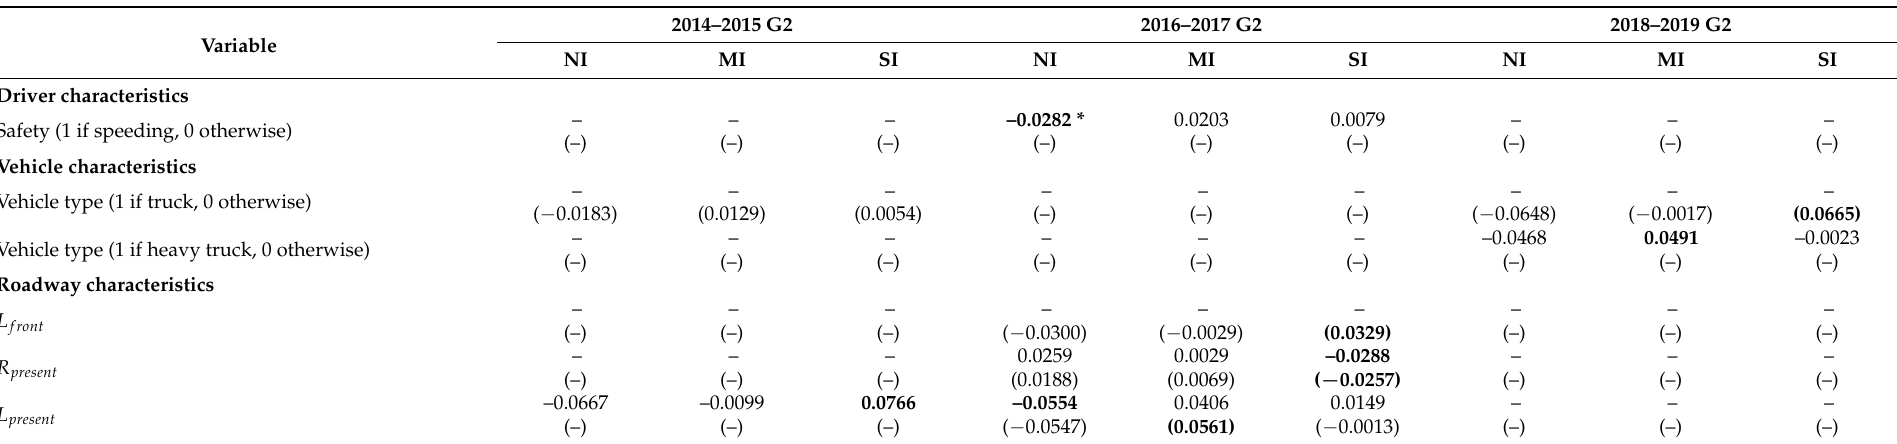
Table 6. The marginal effects of determinants in two-vehicle and multi-vehicle rear-end crashes (effects of multi-vehicle model in parentheses) for